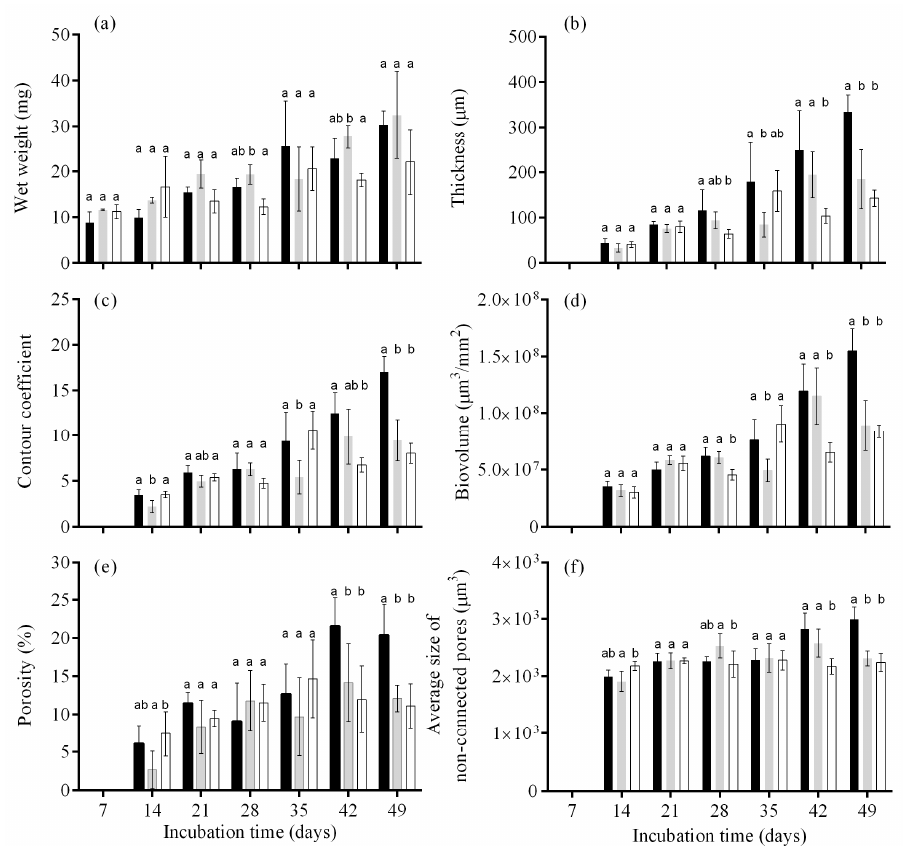
Figure 3. Nodosilinea cf. nodulosa LEGE 10377 biofilm development on different surfaces (glass— black, epoxy resin—grey, CNT composite—white). The parameters analyzed refer to biofilm wet weight ( a ), thickness ( b ), contour coefficient ( c ), biovolume ( d ), porosity ( e ), and average size of non-connected pores ( f ). Mean values and SD from two biological assays with two technical replicates each are represented. For each sampling day, different lowercase letters indicate significant differences between surfaces ( p ≤ 0.05; one-way ANOVA with Tukey’s multiple comparisons test).